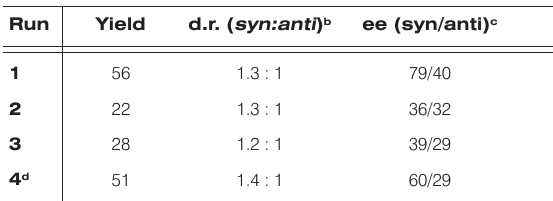
Table 3. Recycling of C1 in the reaction of 5 with 6 in [bdmim]NTf 2a